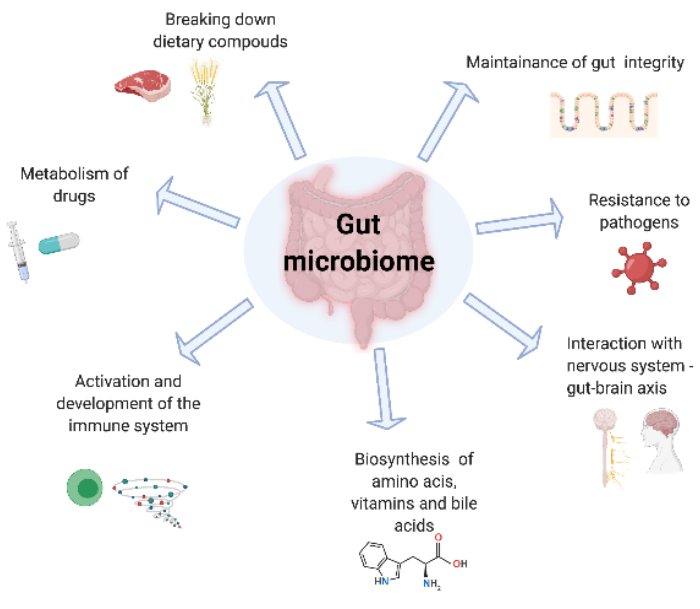
Figure 1. The role of the gut